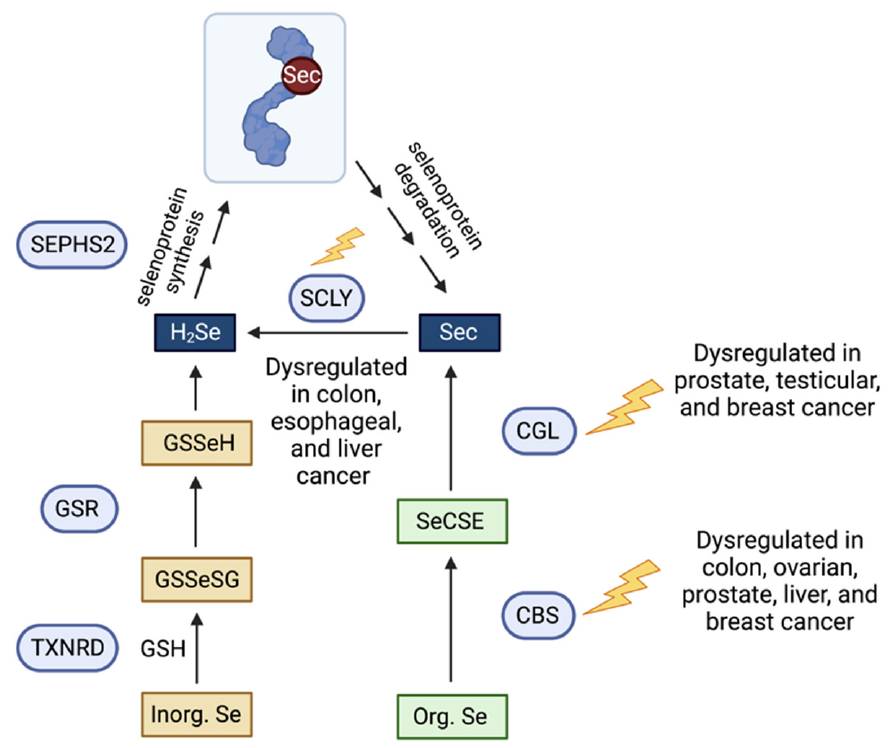
Figure 1. Schematic representation of the organic and inorganic Se metabolic pathways, Sec decomposition and their dysregulation in cancer. Arrows indicate direction of reaction. Blue circles represent enzymes; squares represent selenometabolites. GSH, glutathione; GSR, gluthathione reductase; TXNRD, thioredoxin reductase; GSSeSG, selenodiglutathione; GSSeH, glutathioselenol; H 2 Se, hydrogen selenide; SEPHS2, selenophosphate synthetase 2; Sec, selenocysteine; SCLY, selenocysteine lyase; CGL, cystathionine gamma lyase; CBS, cystathionine beta synthase; SeCSE, selenocystathionine.